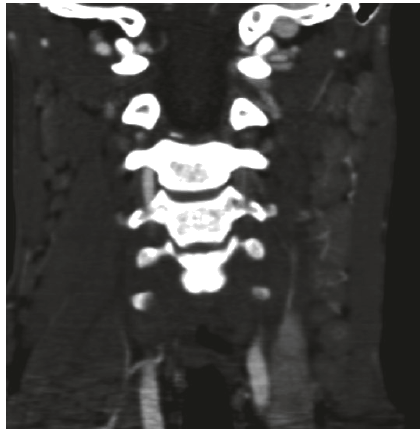
Figure 1: Axial CT angiogram showing bilateral cervical lym- phadenopathy, the largest of which measures 4 × 3.4 × 2.5 cm (arrow). The posterior portion of the node demonstrates arterial phaseenhancementwhiletheanteriorportiondoesnotdemonstrate it. This mixed density mass has the appearance of a necrotic or haemorrhagic lymph node.